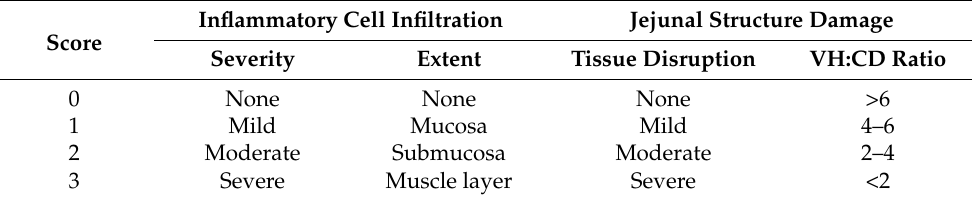
Table 3. Scores of Jejunal Histology in the Broiler Chicken DSS-Induced Enteritis Model. Score